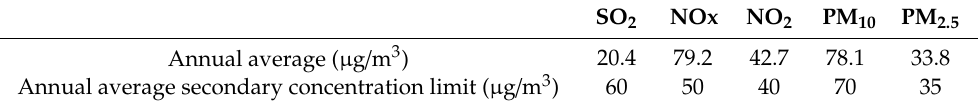
Table 1. Comparison of the Annual Average Value of the Concentration of Air Pollutants in Changchun in 2018 and the Annual Average Secondary Concentration Limit in China’s “Ambient Air Quality Standards”